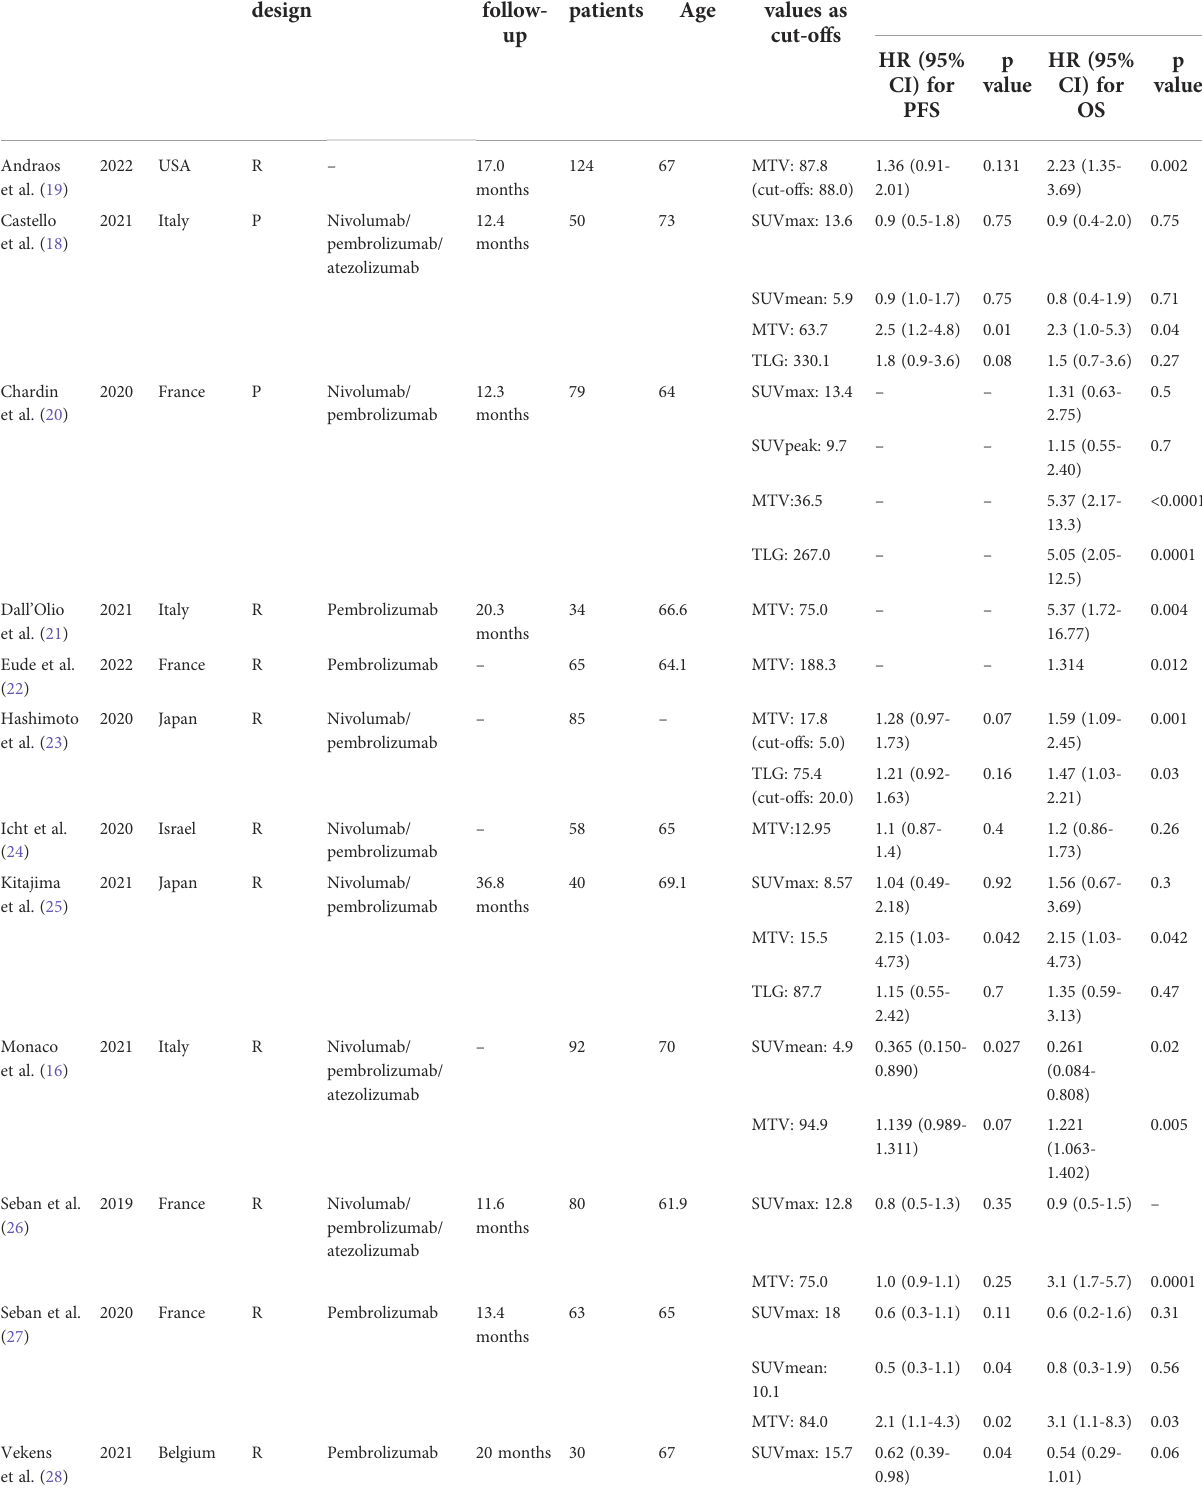
TABLE 1 Characteristics and results of included studies. Studies Year Country Study